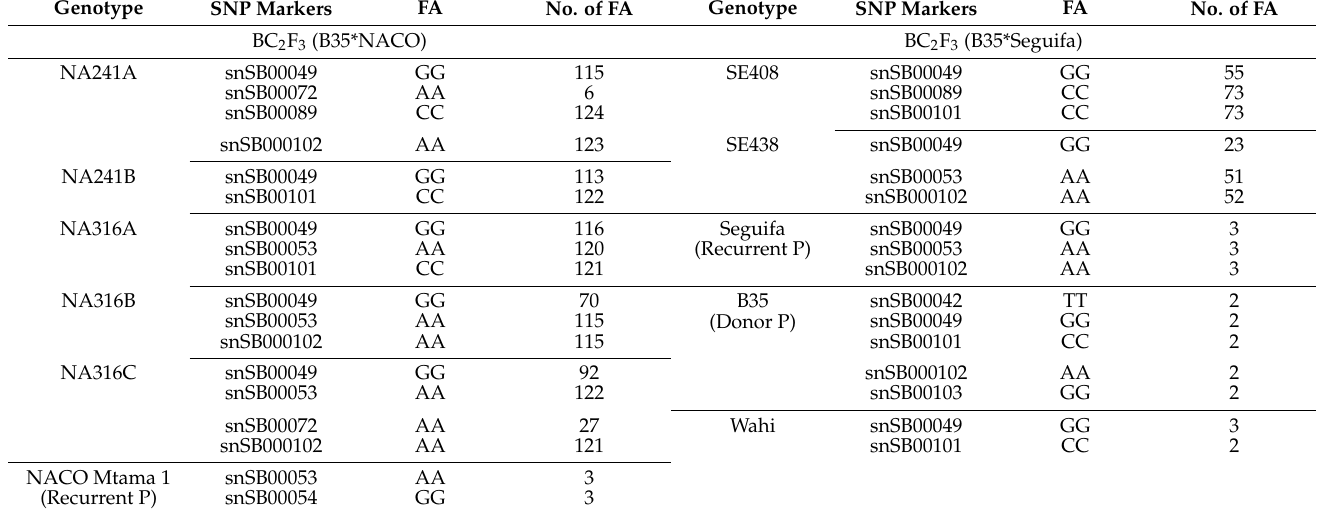
Table 5. Genotypes of BC 2 F 3 populations scored by favourable alleles using SNP markers. Genotype